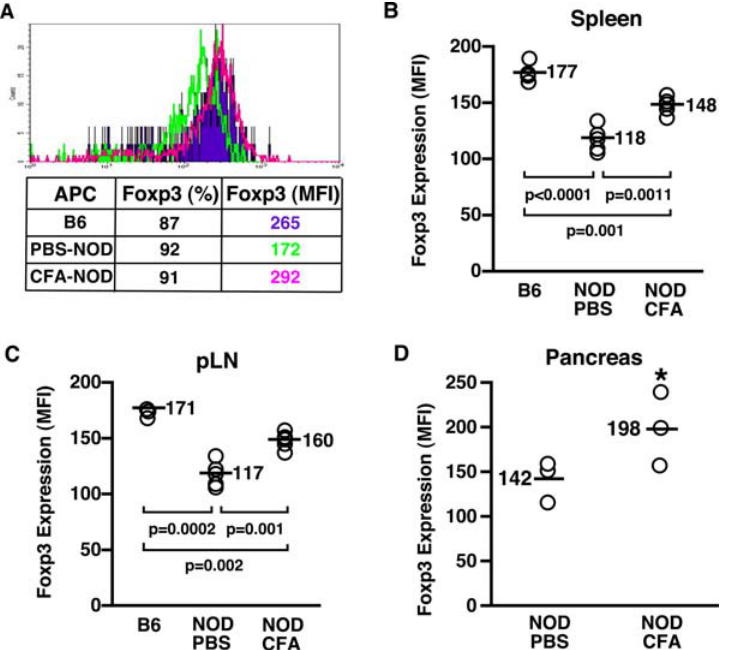
Figure 4. CFA treatment enhances Foxp3 expression by CD4 + CD25 + regulatory T cells invivo . CD4 + CD25 + regulatory T cells were cultured for 24 hrs with APC (irradiated T cell-depleted spleen cells) pooled from 11 week-old B6 or NOD mice injected with PBS or CFA three weeks earlier and anti-CD3 antibody (A). Spleen (B), pancreatic LN (pLN) (C) and pancreas (D) were harvested from 11 week-old B6 or NOD mice injected with PBS or CFA three weeks earlier. Cells were labeled with anti-CD4, CD25 and Foxp3 antibodies and analyzed by FACS H gating on CD4 + CD25 + cells (A–D). Each point represents an individual animal (B–D). An * indicates a significant difference from PBS-treated NOD ( p , 0.05).